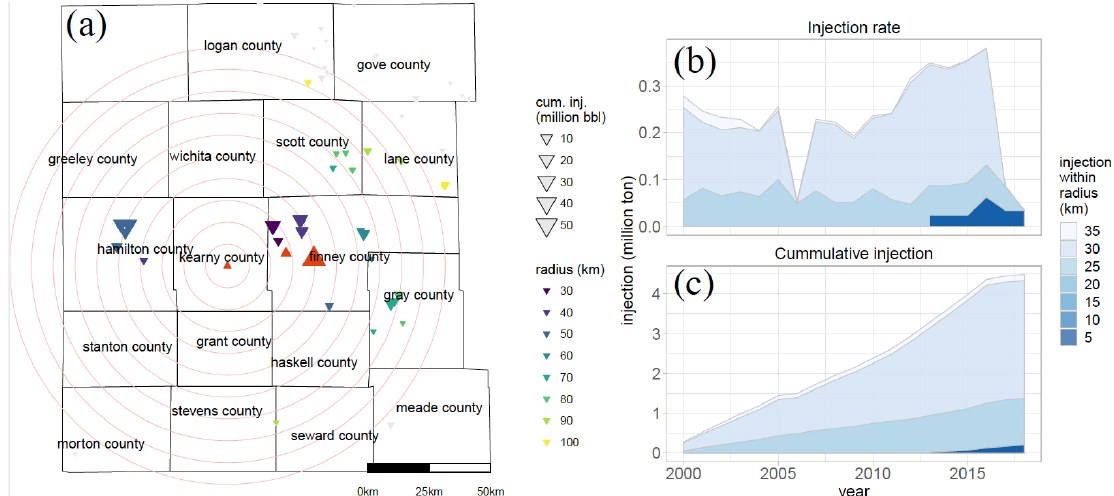
Figure 3. Patterson area ( a ) wells that inject into the Arbuckle aquifer in western Kansas and their injection volumes, including the City of Lakin well for which fall-off test measurements are available (circles show 10 km increments). Red upward triangles represent Class I wells for which more data are available, and downward triangles represent Class II injection wells. Injection rate ( b ) and cumulative injection ( c ) volume in the Patterson area are also shown.